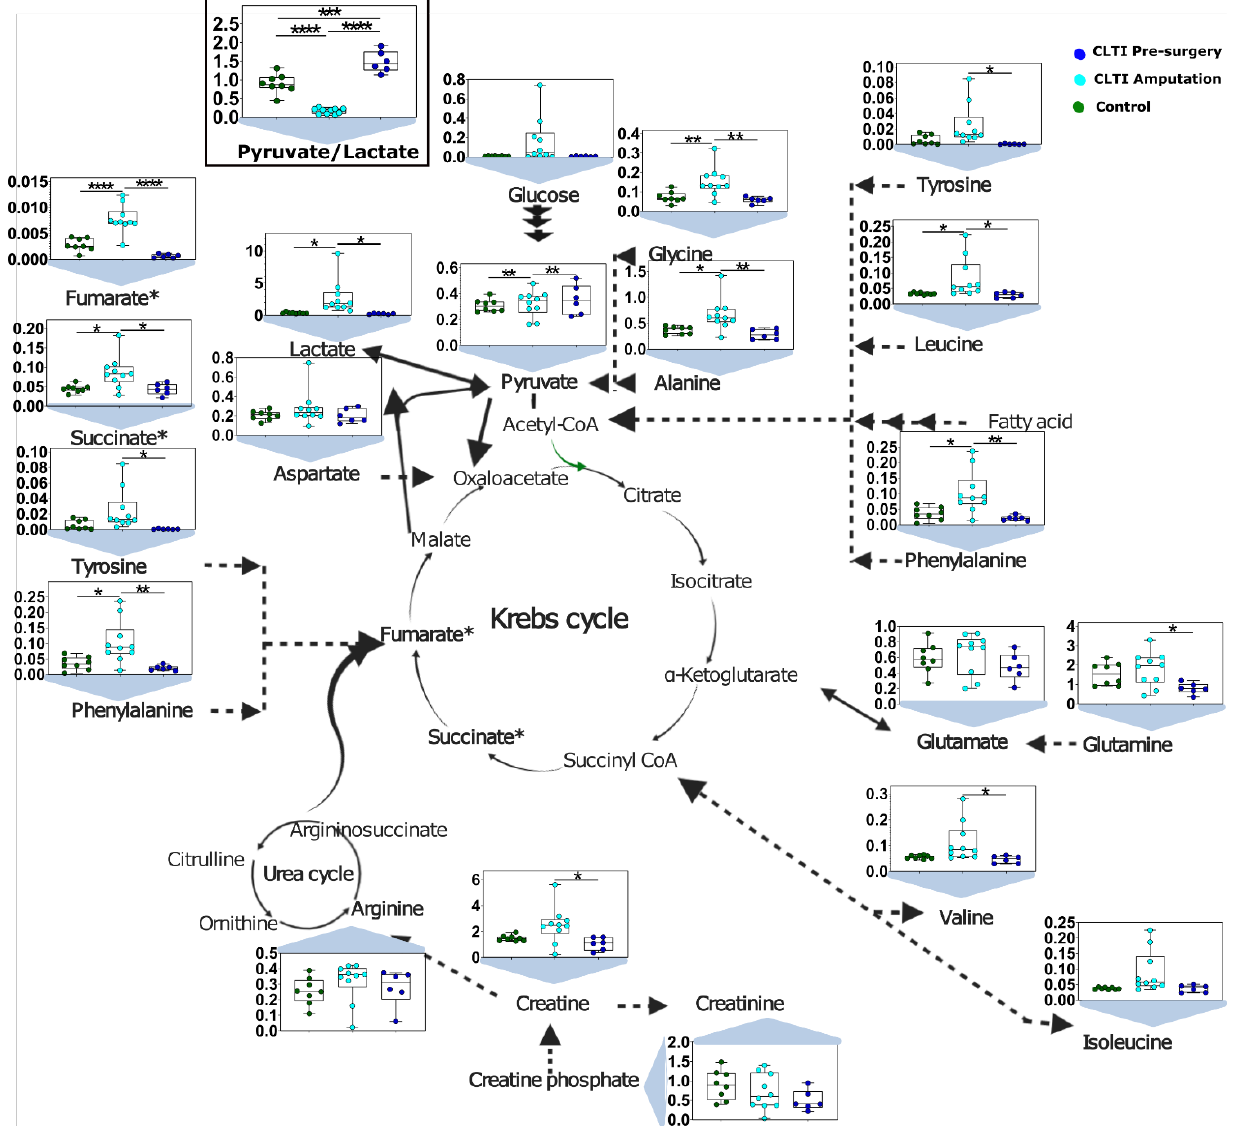
Figure 4. Metabolite Changes in the ischemic CLTI limb muscle. Graphical depiction and quantitative analysis of selected metabolite concentrations in muscle specimens. Box and whisker plots with 95% confidence intervals are presented for quantified amino acids with concentrations in mM. Analysis was performed using one-way ANOVA with Tukey’s multiple comparisons test. * p < 0.05, ** p < 0.01, *** p < 0.001, **** p < 0.00001.